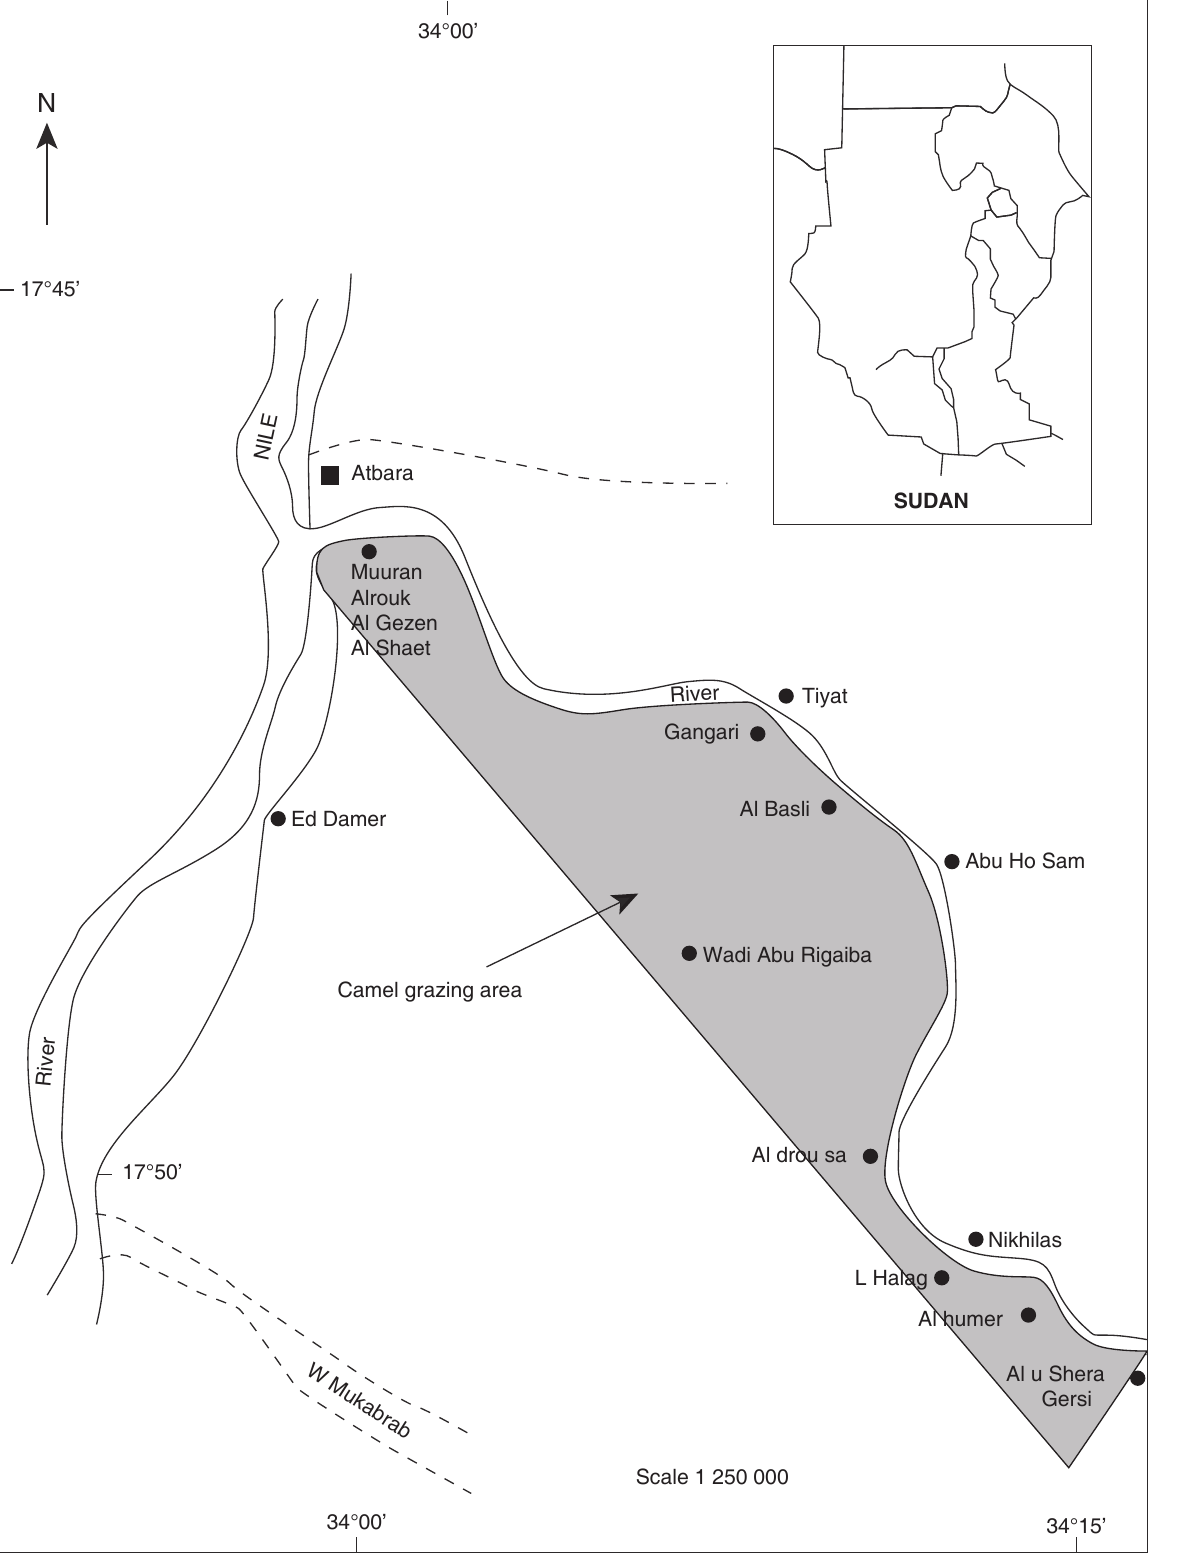
Map of the study area in Nothern Sudan showing the localities from where ticks were colected ( ● ) and Atbara Research Laboratory ( ■